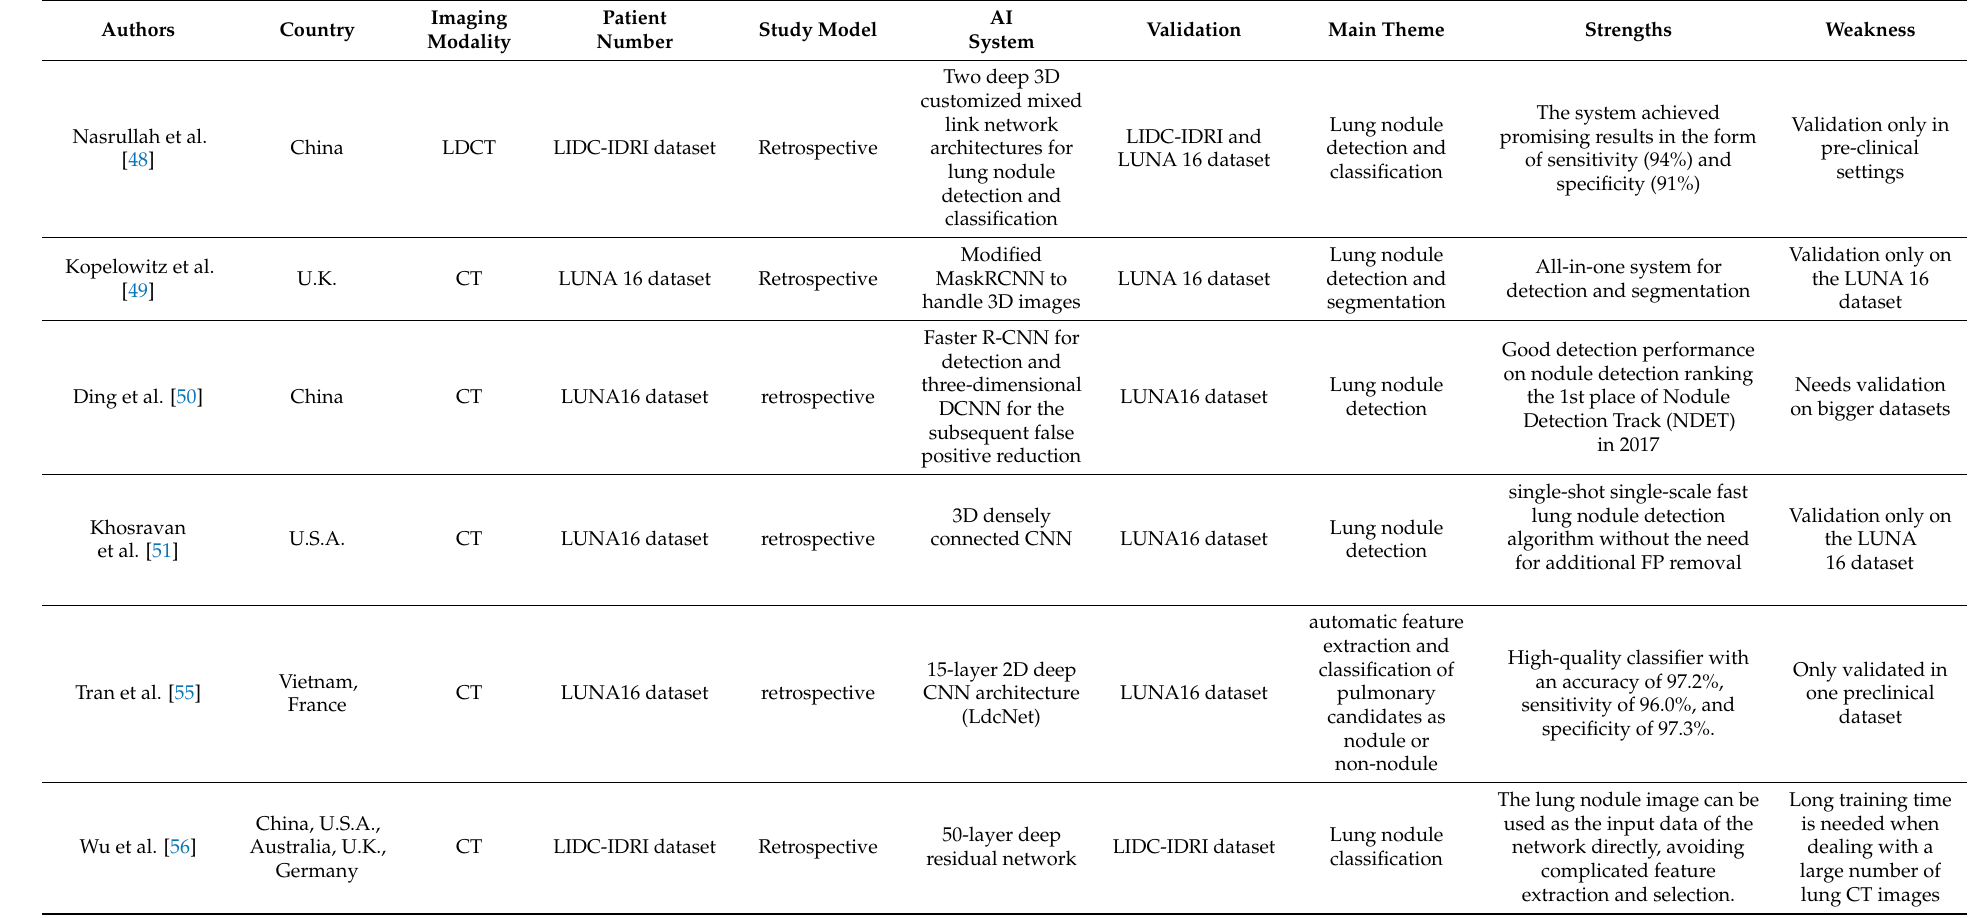
Table 2. The table lists the characteristics of different studies aiming at lung nodules screening and